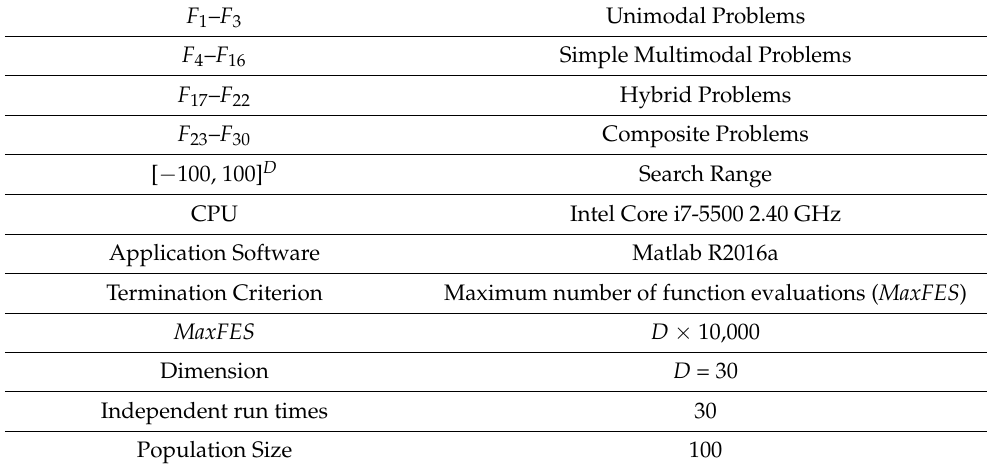
Table 2. Details of CEC2014 benchmark problems and experimental setup.